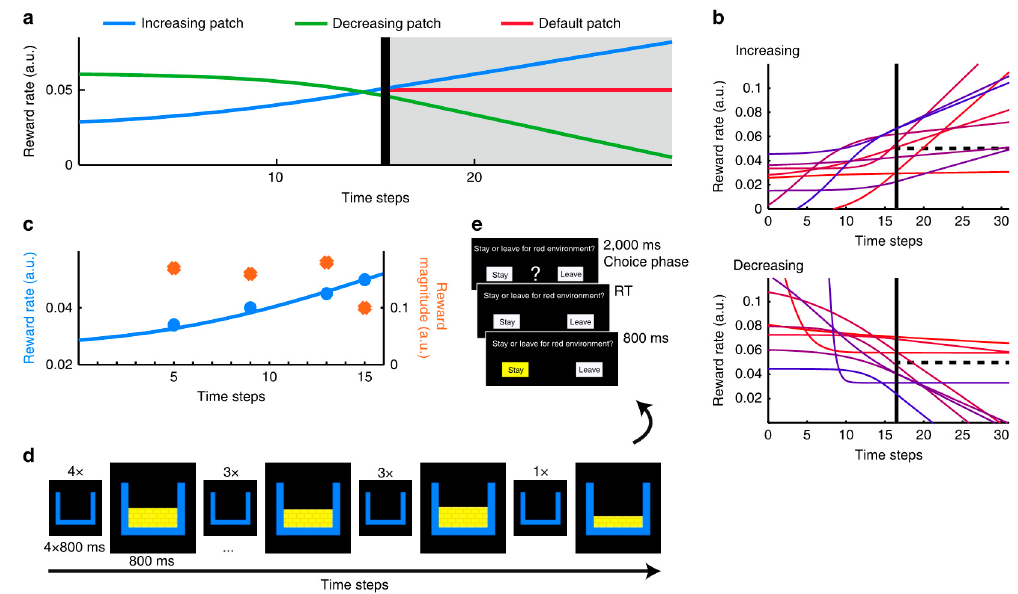
Figure 3. Patch Leaving Task used in the study by Wittmann et al. In this task, subjects decided whether to stay in the current patch or leave to another patch, relying on the experiences of past actions and reward outcomes. ( a ) Task flow. The x -axis is time steps, at which subjects take one action. The y -axis is an average reward rate. The subjects are either in the patches with gradually increasing reward rates (Increasing patch: the line in blue), or in the patches with decreasing reward rates (Decreasing patch: the line in green). The subjects take one action at each time step and receive a reward or non-reward. Then, after some time steps, they decided to stay or leave at the time predetermined by the experimenter (the thick vertical black line). After this patch leaving (staying) decision (the period right side of the thick vertical black line), the subjects continue the cycles of taking an action and receiving a reward (or non-reward). ( b ) Trajectories of average reward rates. There are several possible programmed trajectories for both increasing patch and decreasing patch. ( c ) Calculations of the average reward rates. The average reward rate is calculated by dividing an amount of the reward at each time step by a probability of reward occurrence at each time step. ( d ) Sequence of actions and rewards. There are cases in which a reward follows an action (yellow contents in buckets), or cases in which a reward does not follow an action (empty buckets). The amount of the content corresponds to the amount of the rewards. ( e ) Patch leaving decision. After the presentation of options (Stay or Leave), the subjects have to respond within 2000 milliseconds and the display of the chosen option appears 800 milliseconds after the decision response (Image adapted with permission from Wittmann et al., Nature Communications, 2016; Nature Publishing Group [66]).